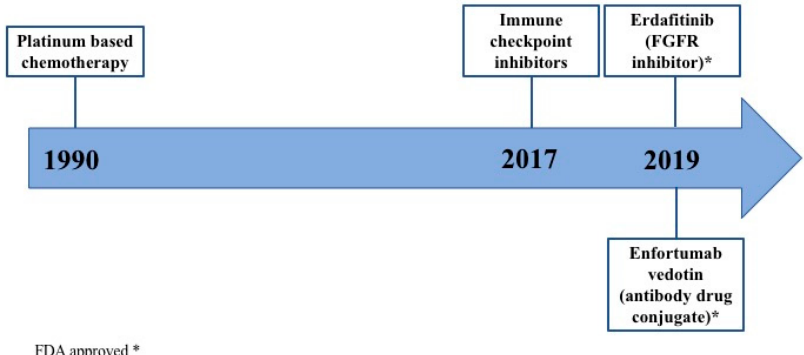
Figure 3. Evolution of practice changing treatments for metastatic urothelial carcinoma. For many years, platinum-based chemotherapy has been the gold standard treatment for patients with metastatic urothelial carcinoma. Since 2017, immune checkpoint inhibitors entered in the treatment scenario. In 2019, two new treatment strategies showed promising results and have been granted accelerated approval by the US Food and Drug Administration: erdafitinib and enfortumab vedotin.